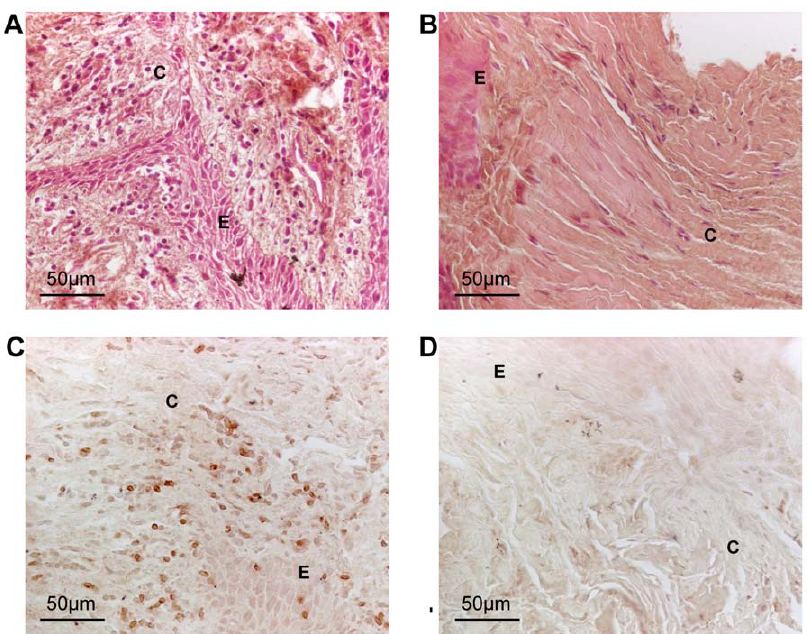
Figure 1. H&E and CD3-stained paraffin-embedded gingival biopsies obtained from one representative patient with periodontitis. A. H&E staining of inflammatory cells in periodontitis-affected sections. B. H&E staining of inflammatory cells in healthy gingival sections. C. Staining of the T-cell marker CD3 in periodontitis-affected sections. D. Staining of the T-cell marker CD3 in healthy sections. E, epithelium, C, connective tissue.